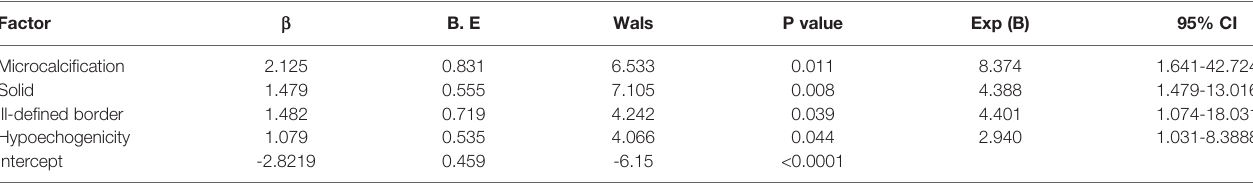
TABLE 3 | Multivariate binary logistic regression in the training dataset. Factor